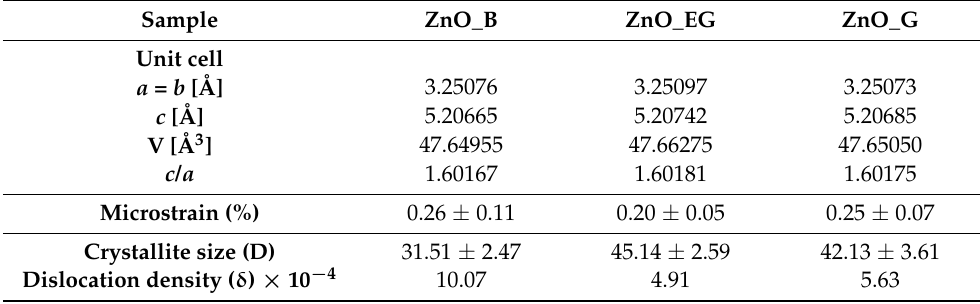
Table 2. The calculated lattice parameters for the ZnO_B, ZnO_EG and ZnO_G samples.